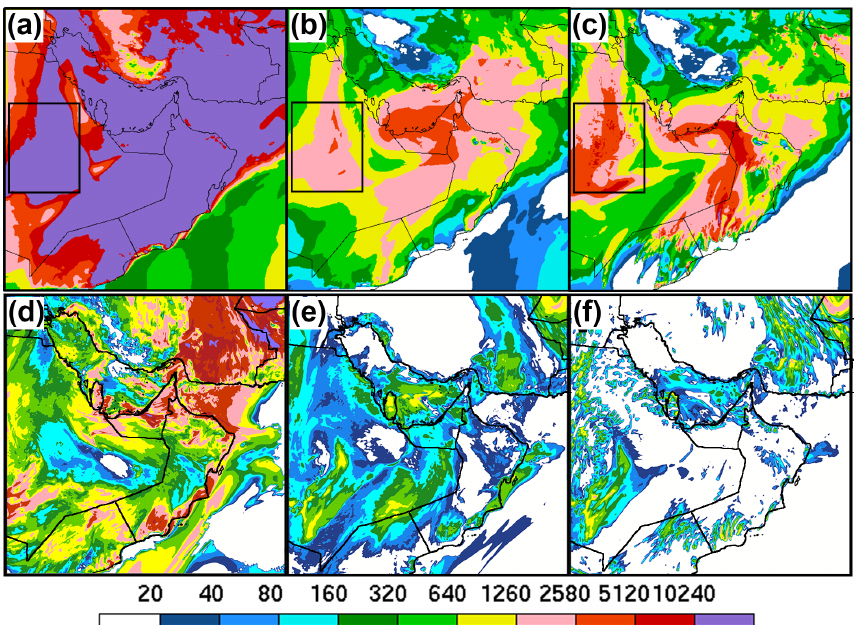
Figure 5. Simulated dust mass (µgm − 3 ) at 09:30UTC on 4 August 2016 from the lowest model level (36ma.g.l.) in RAMS and from the near surface (945hPa) in WRF-Chem using the (a, d) Idealized dust lofting, (b, e) Ginoux dust sources, and (c, f) Walker dust sources from the simulations from (a–c) RAMS and (d–f) WRF-Chem. The black box over the central Arabian Peninsula denotes the analysis region shown in Fig.